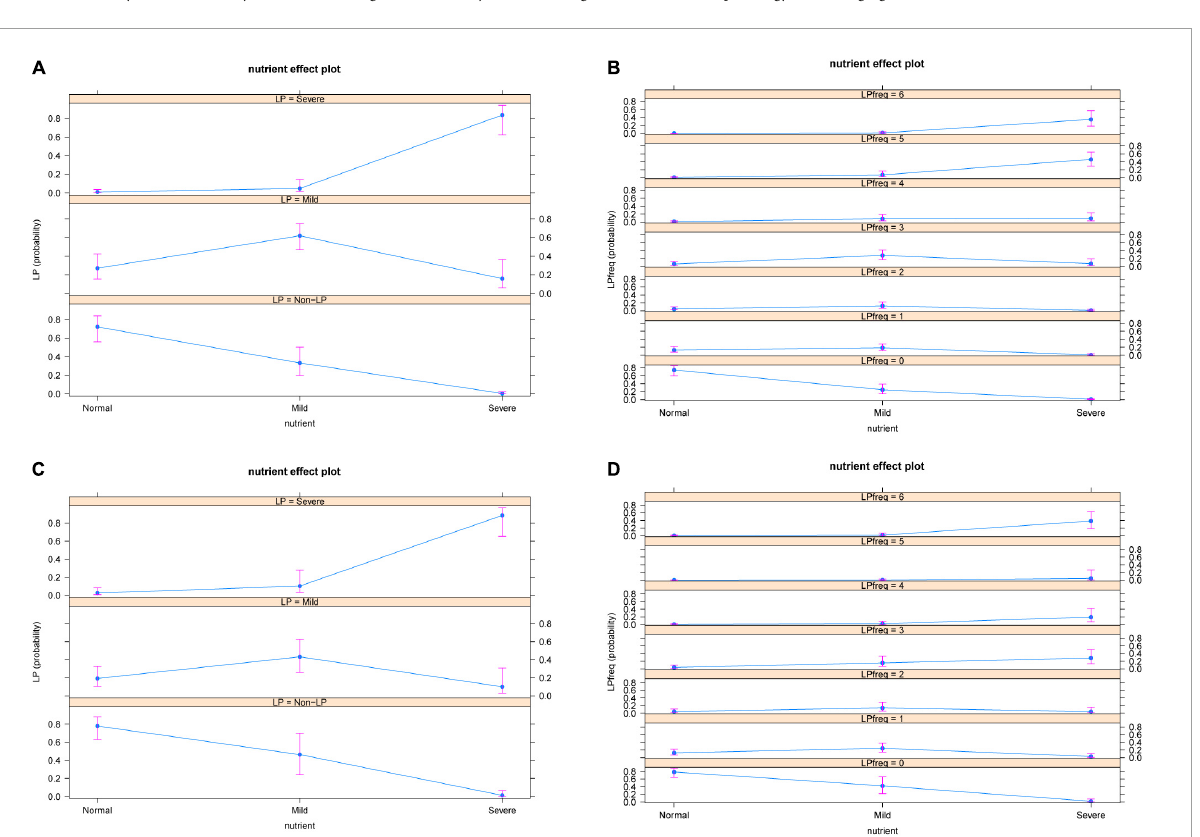
FIGURE3 Severity (A) and frequency (B) of nutritional status and occurrence of LP in adolescent patients. Severity (C) and frequency (D) of nutritional status and occurrence of LP in adult patients. The results showed that the severity and frequency of LP increased with the deterioration of patients’ nutritional status. LP: